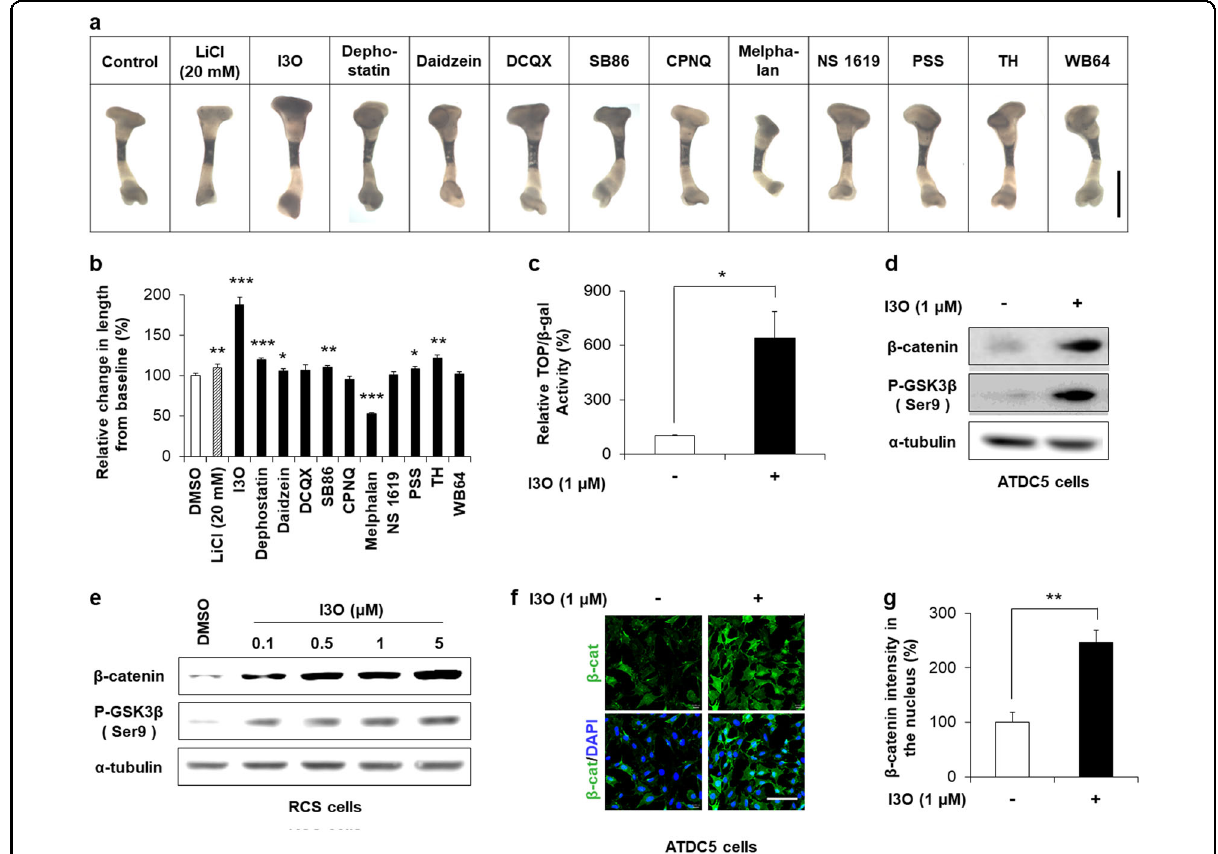
Fig. 1 Identi fi cation of I3O as an enhancer for the elongation of ex vivo cultured tibia. a and b Tibias isolated from E15.5 mice were cultured ex vivo for 6 days with 5 μ M of each small molecule. LiCl (20 mM) was used as a positive control for activation of the Wnt/ β -catenin pathway. Representative images of tibias after 6 days of culture with the indicated small molecules a . Scale bar, 1 mm. Longitudinal growth of tibias over 6 days of culture (the difference between the beginning and end of culture) was quanti fi ed (mean± s.e.m., n = 3 per group, * P < 0.05, ** P < 0.005, and *** P < 0.0005 versus DMSO-treated control) b . c For the luciferase reporter assay, ATDC5 cells cotransfected with pTOPFlash and pCMV- β -gal were treated with I3O for 24 h (mean ± s.e.m., n = 2 per group, * P < 0.05). d – g ATDC5 or RCS cells were treated with I3O for 24 h, followed by immunoblotting to detect β -catenin, GSK3 β , and α -tubulin d , e and immuno fl uorescence staining to visualize β -catenin f . Scale bar, 0.1 mm. The intensities of β -catenin were analyzed from the immuno fl uorescence staining images using NIS Elements V3.2 software (mean ± s.e.m., n = 3 per group, ** P < 0.005)